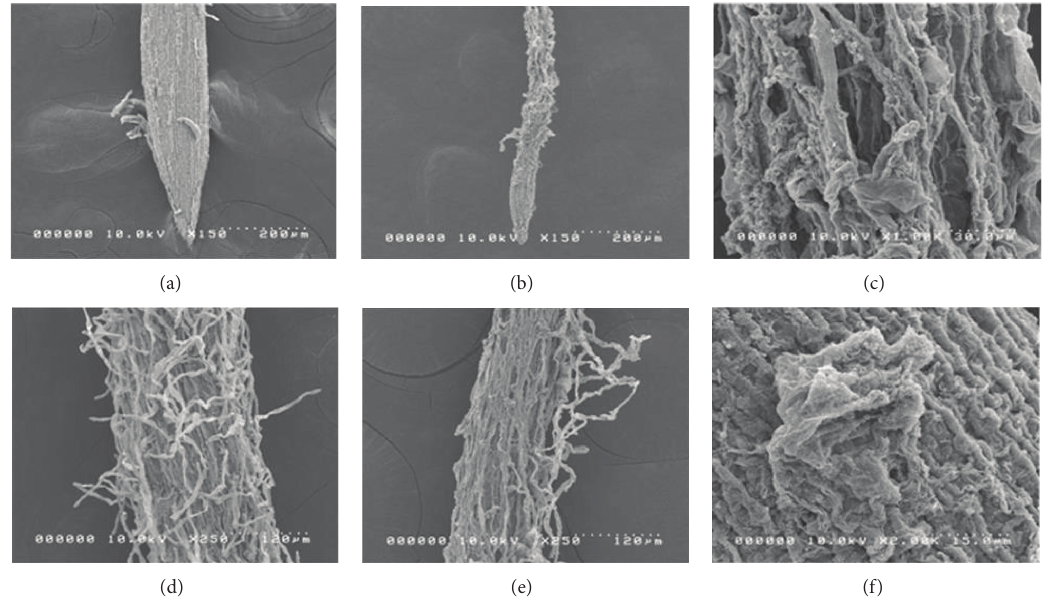
Figure 7: Behavior of graphene (1000mgL −1 ) on the root surface of tomato seedlings grown in Hoagland medium. (a, d) SEM image of the untreated control of tomato root elongation and root hair zone, respectively. (b) Root elongation zone of tomato root and (c, e, and f) showing surface detachment and aggregates of G on the tomato roots surface treated with G